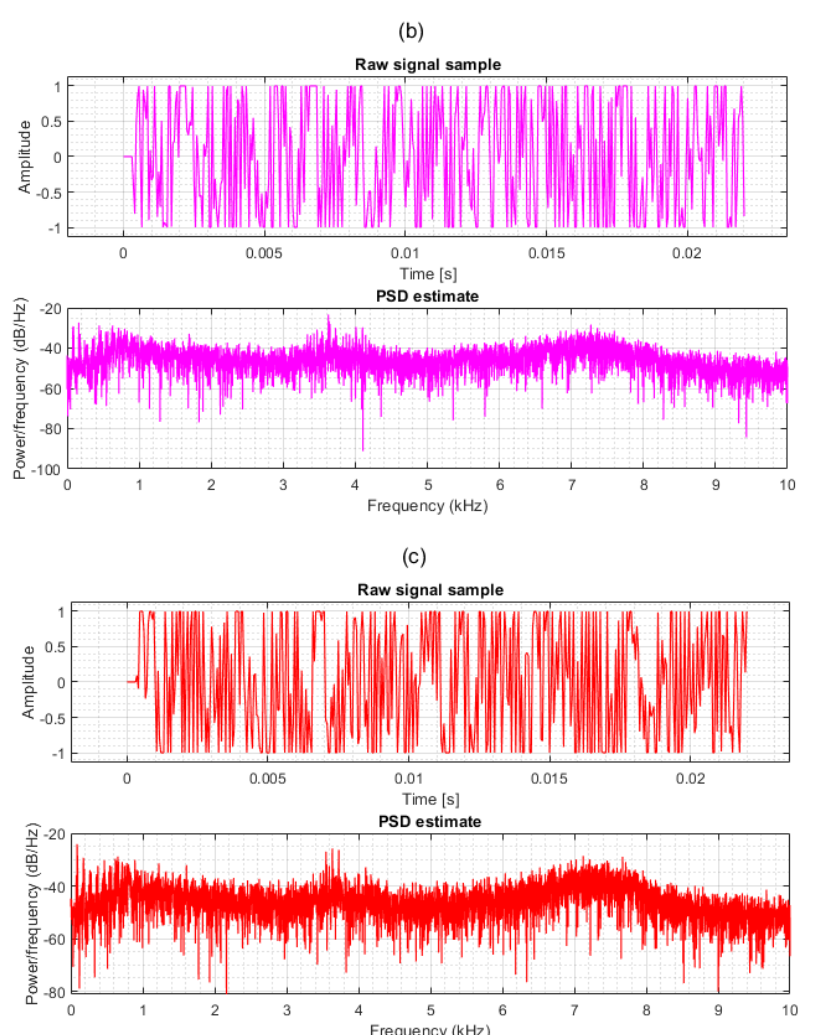
Figure 11. Samples of recorded audio signals along with their PSD estimates: ( a ) all rotors healthy, ( b ) single damaged rotor, opposite microphone, ( c ) single damaged rotor, closest